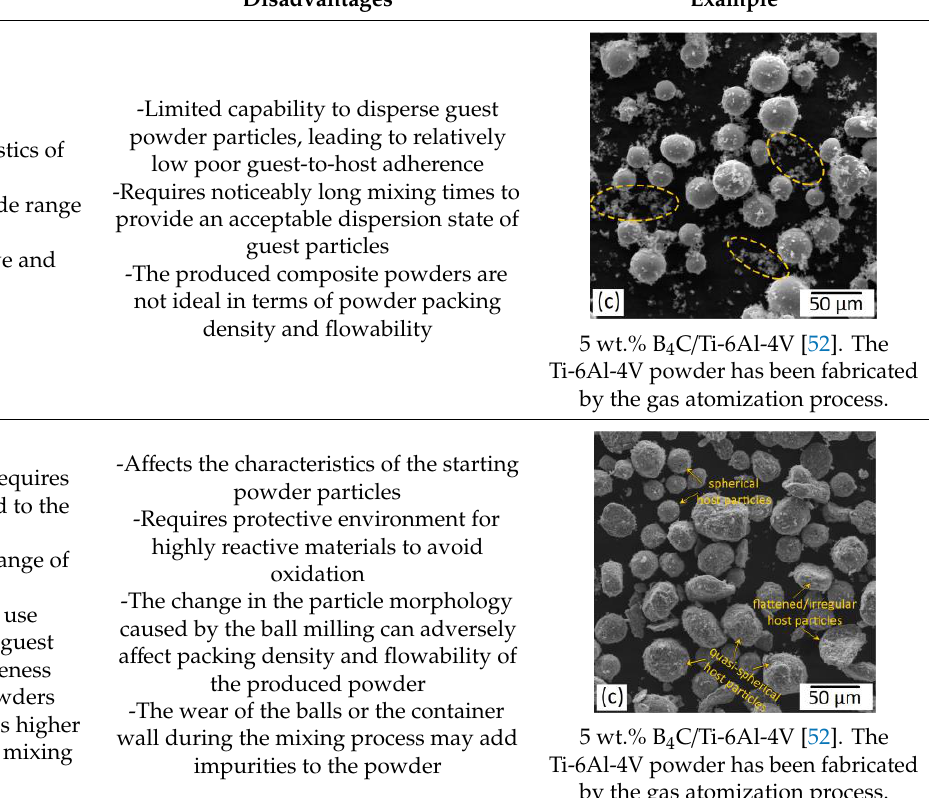
Table 1. The methods used to produce composite powders for selective laser melting (SLM) applications.